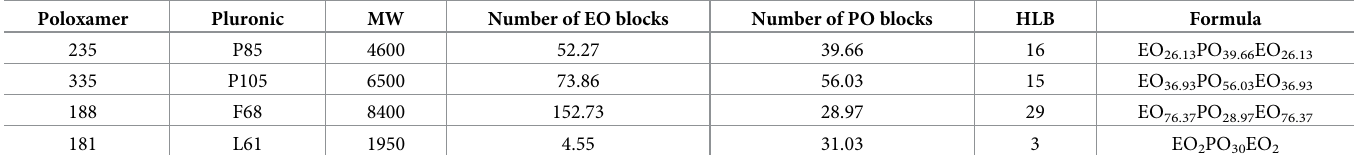
Table 1. Pluronics used in this Study, with their Name, Block Composition, Hydrophilic-Lipophilic Balance (HLB) and General Formula. L, F or P refers to Liquid, Flake, or Paste Physical Forms, respectively.